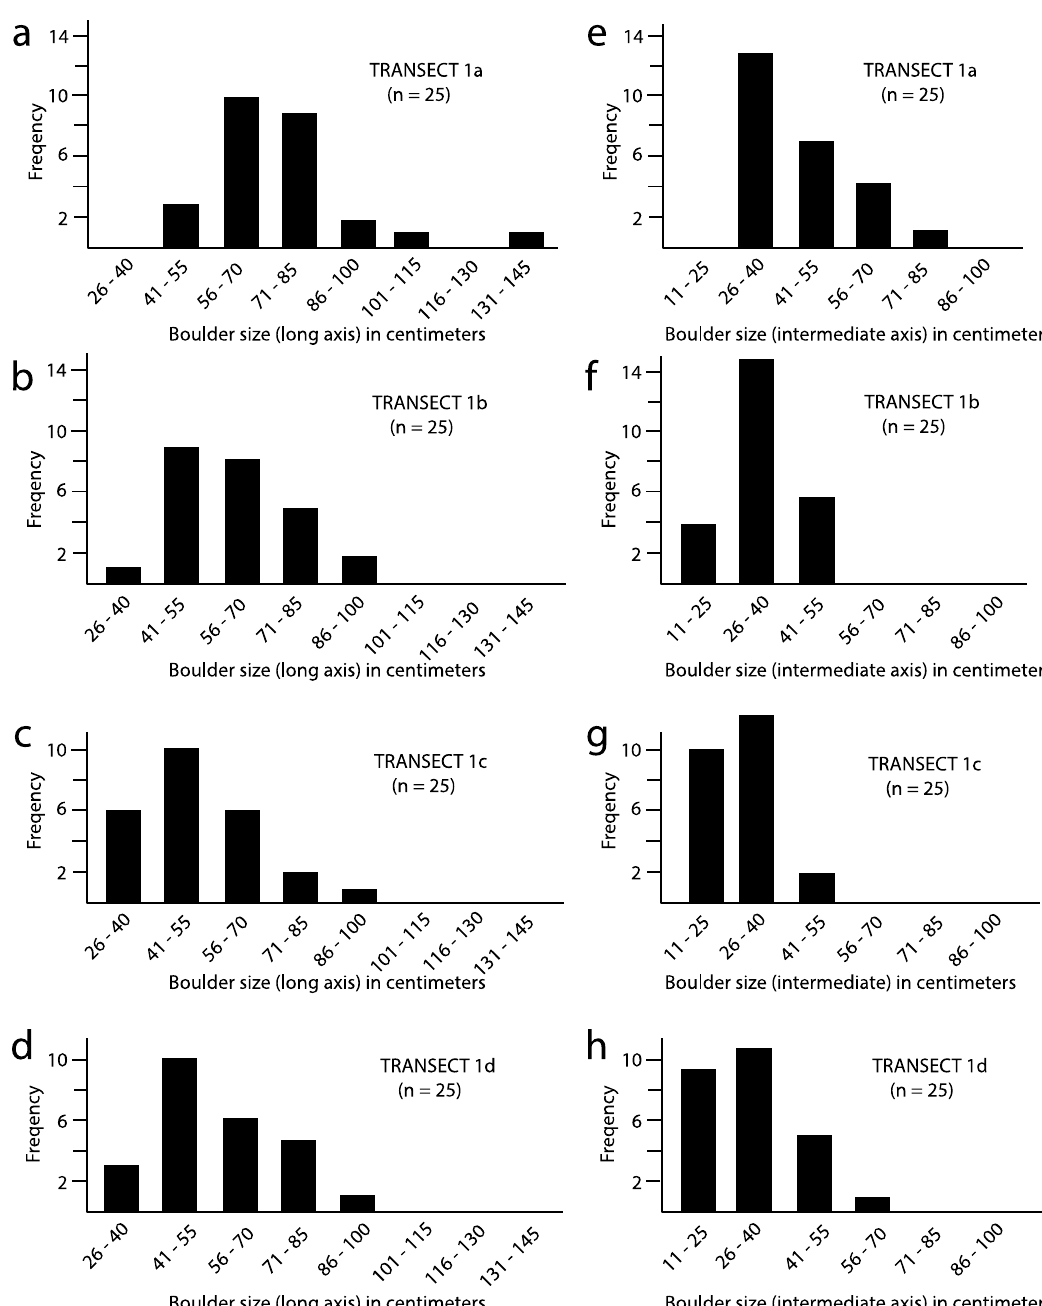
Figure 9. Parallel sets of bar graphs used to appraise variations in the long and intermediate axes on boulders from barrier #1; ( a ) Long axis from boulders in Transect 1a; ( b ) Long axis from boulders in Transect 1b; ( c ) Long axis from boulders in Transect 1c; ( d ) Long axis from boulders in Transect 1d; ( e ) intermediate axes from boulders in Transect 1a; ( f ); Intermediate axis from boulders in Transect 1b; ( g ); Intermediate axis from boulders in Transect 1c; ( h ) Intermediate axis from boulders in Transect